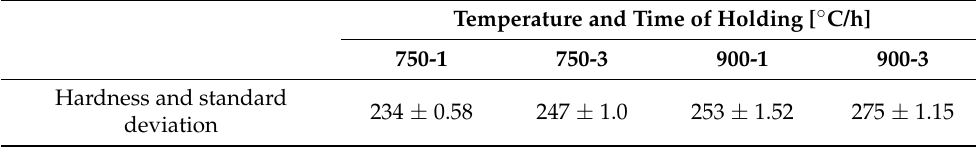
Table 4. Hardness of examined cast steel (averages of five measurements) HV 10.